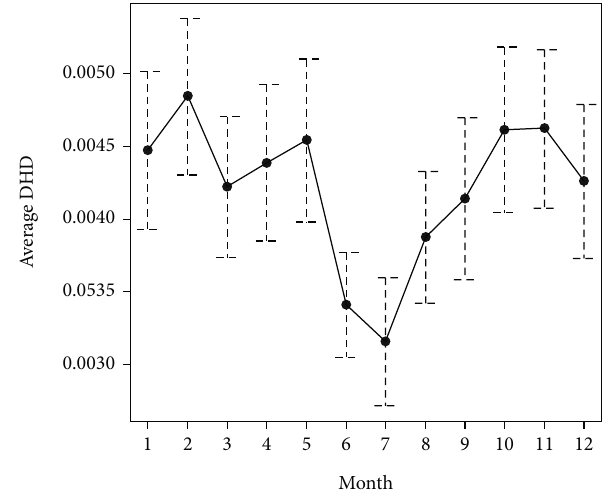
Figure 4: Mean and seasonal variability of DHD Table 2: Mean value of the de fi ned daily dose per 1000 inhabitants and day (DHD) of mebendazole and pyrantel in each season (2016 – 2020). Spring Summer Fall Winter